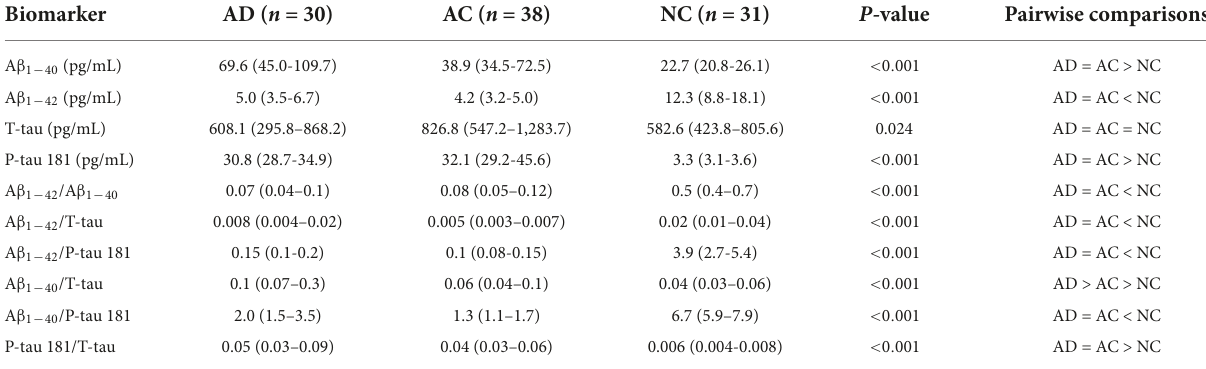
TABLE 2 Plasma biomarker levels in the studied participants.